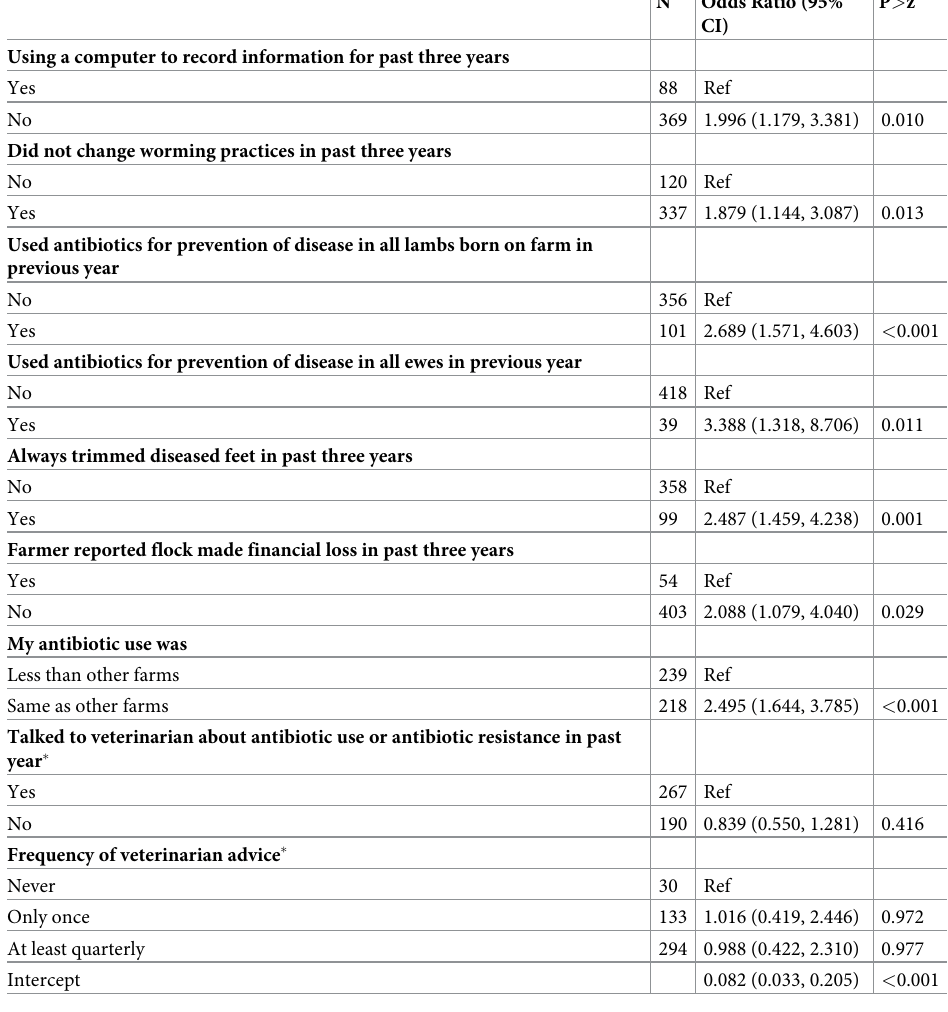
N Odds Ratio (95% P > z CI) 337 1.879 (1.144, 3.087) 0.013